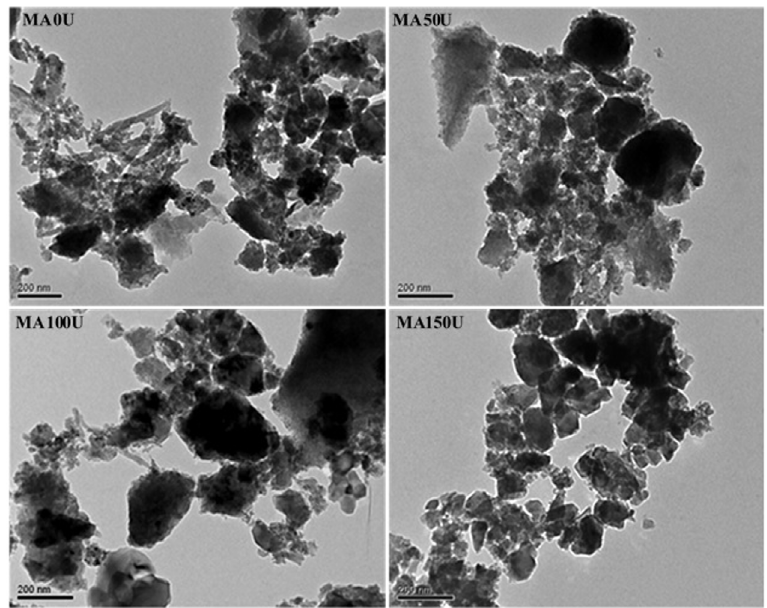
Figure 6. TEM images of the samples prepared from the use of distinct masses of urea during the microwave assisted combustion.